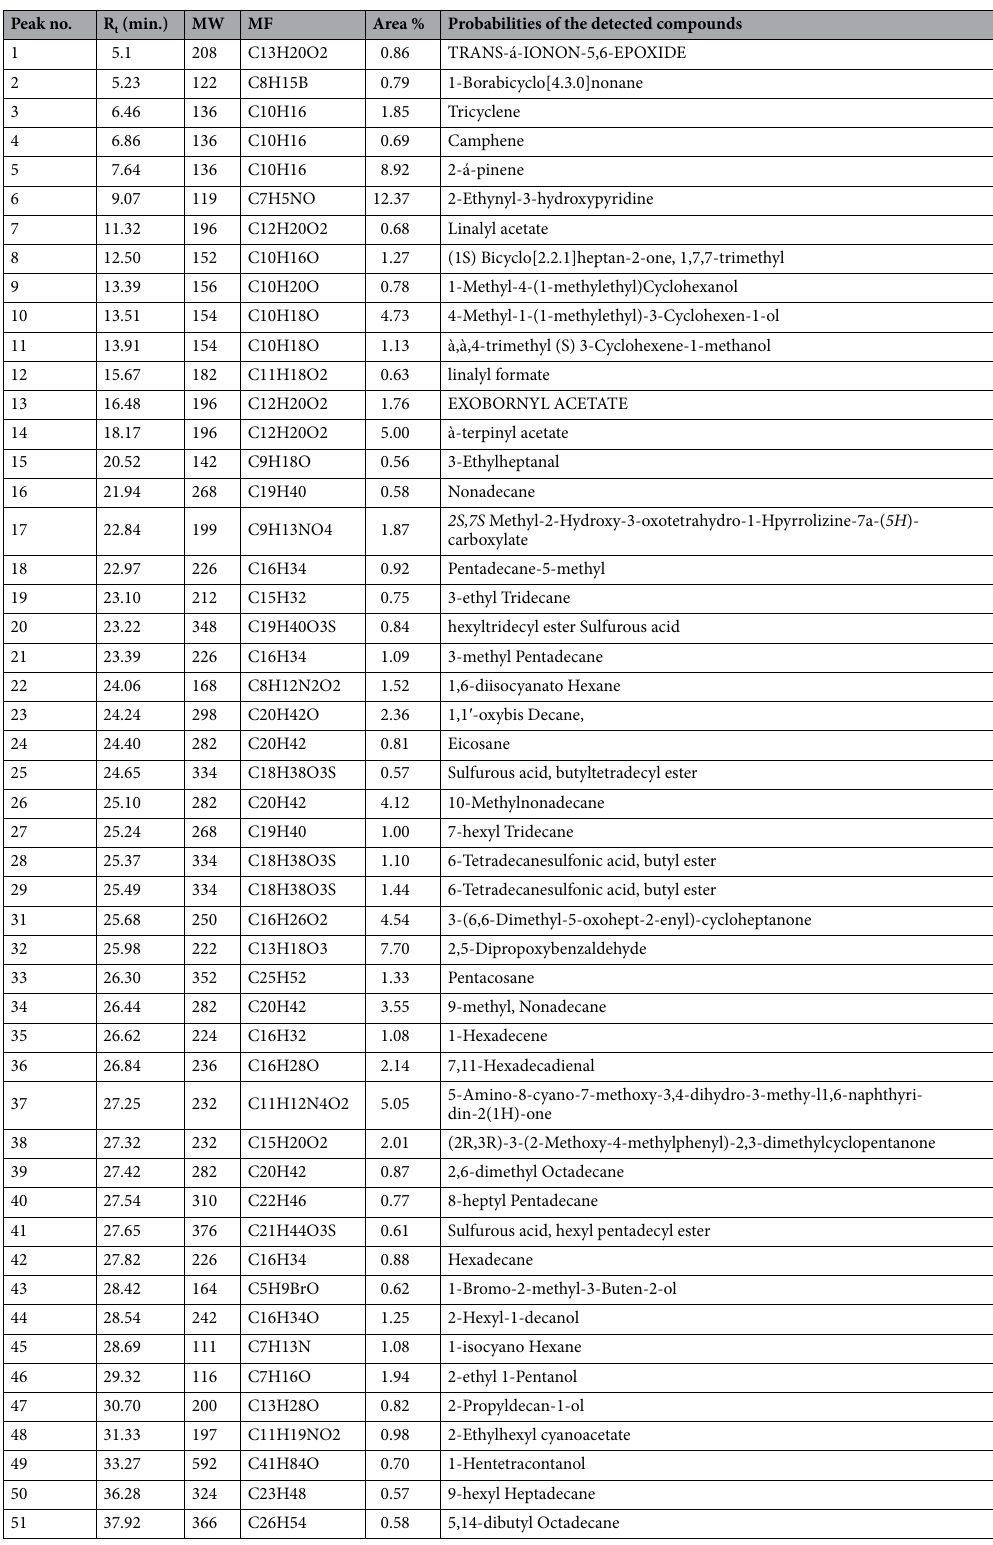
Table 10. GC/MS analysis of Thymus vulgaris